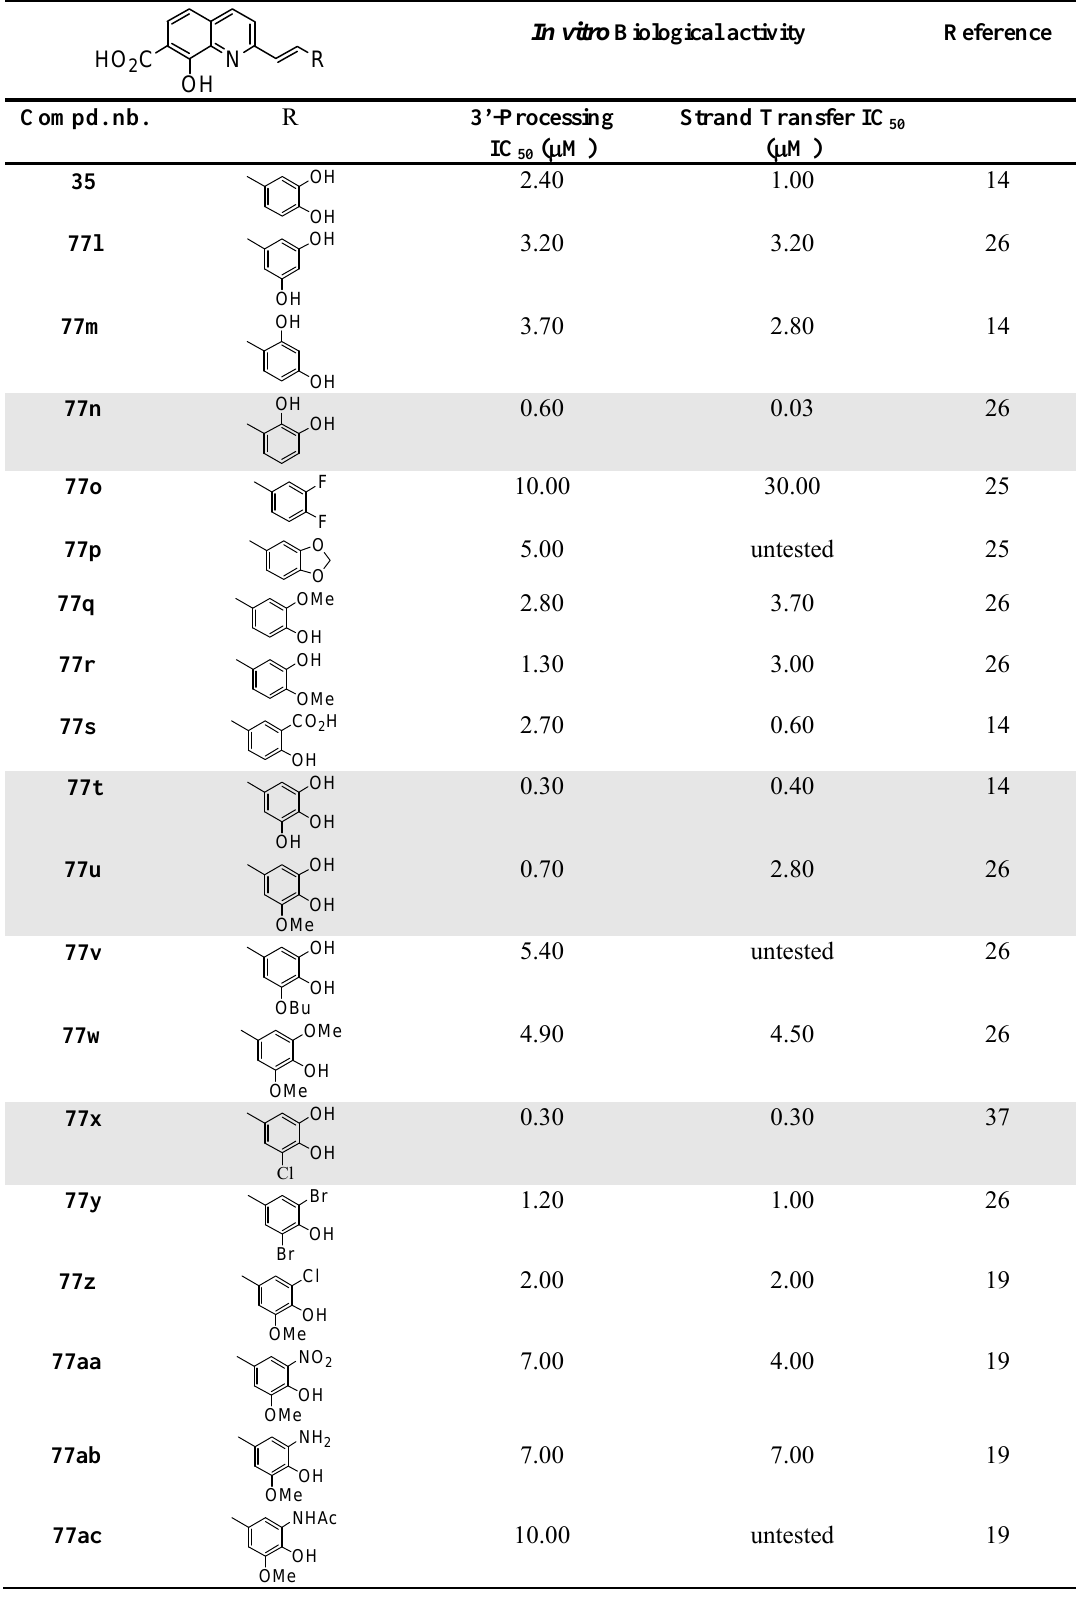
Table 7. Influence of the ancillary ring on the HIV-1 IN inhibitory potency of 8-hydroxy- 2-styryl-quinoline-7-carboxylic acids. In vitro Biological activity Reference RN OHHO 2 C Strand Transfer IC Compd. nb. R 3’-Processing ( μ M) IC 50